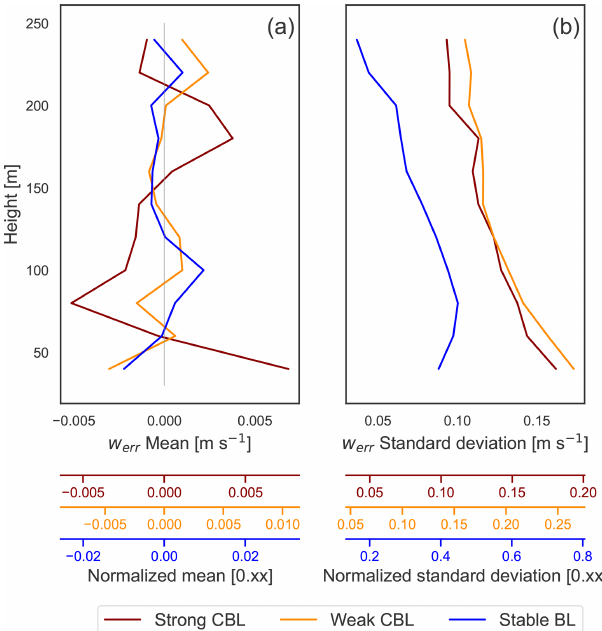
Figure 19. Vertical velocity measurement error moments for the vertically pointed beam. Error is with respect to the pointwise